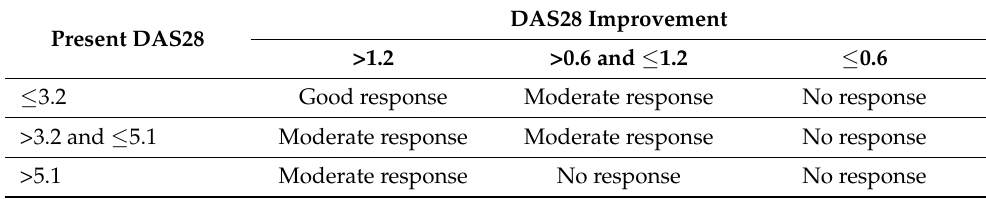
Table 3. EULAR therapy response criteria using